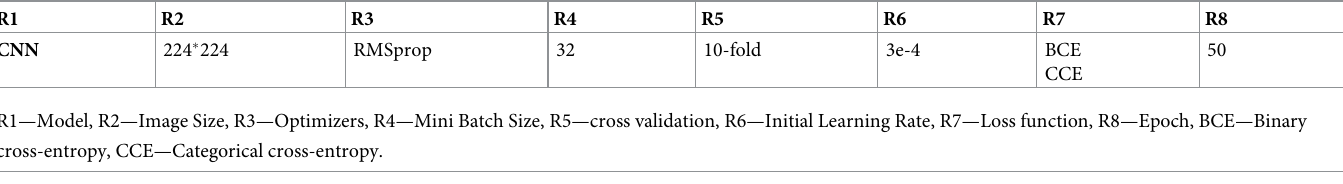
Table 1. Hyper-parameters of the build CNN model and preferred weights in this study.